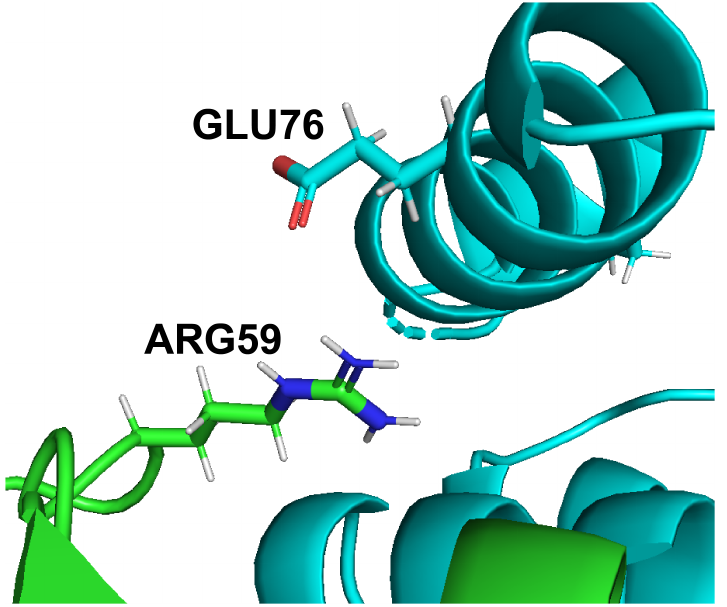
Figure 1. Sidechain visualization of Arg59 on Barnase (green) and Glu76 on Barstar (teal). Arg59 and Glu76 are within 4 Å and are oppositely charged amino acids, so they are predicted to form a salt bridge by